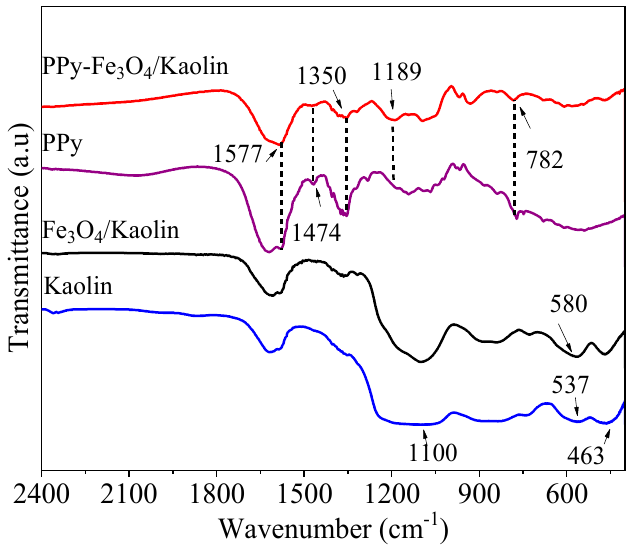
Figure 5. FT-IR of the as-prepared three materials.